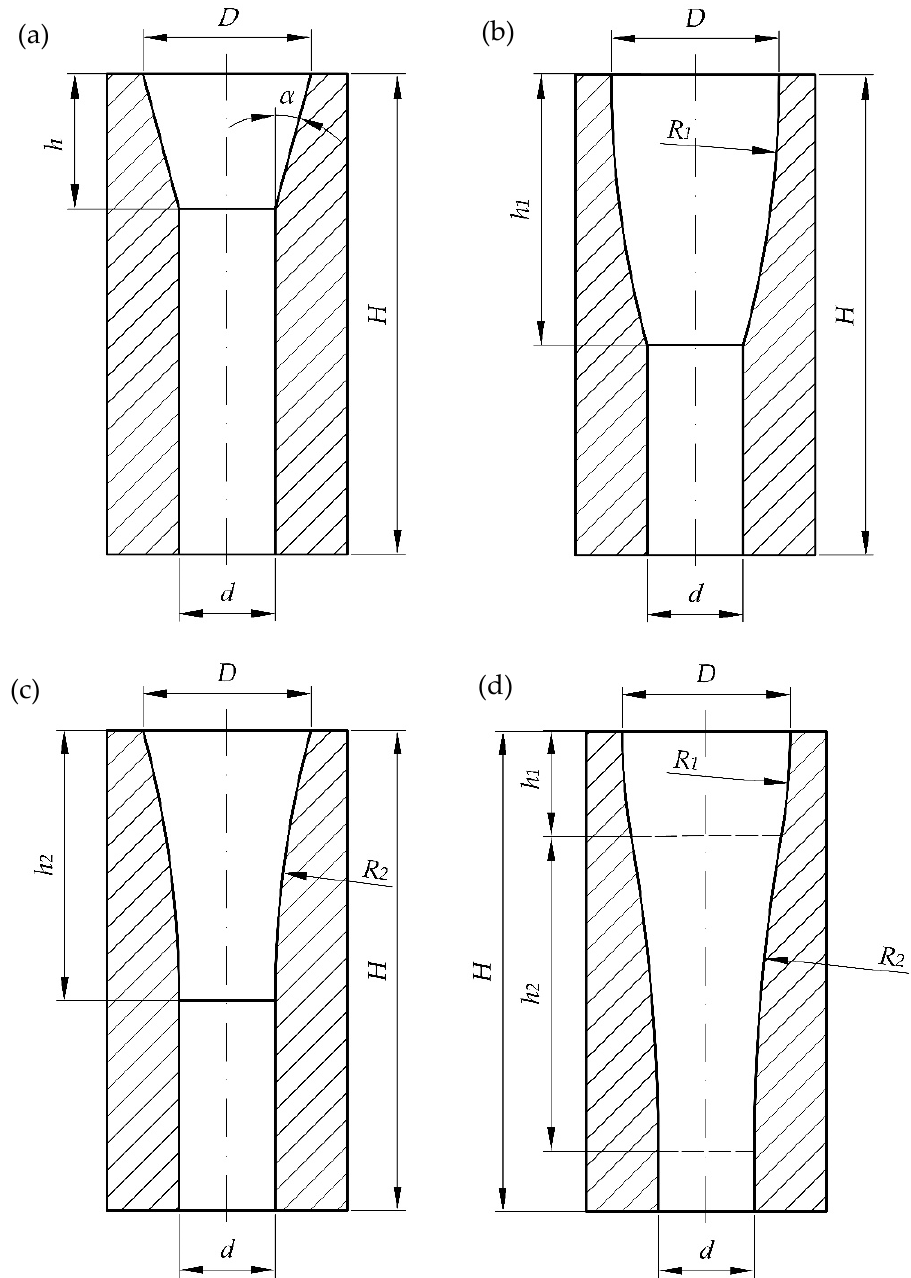
Figure 3. Shapes of the dies under analysis: ( a ) conical-cylindrical (CS), ( b ) with a convex spherical compression section (WK), ( c ) with a concave spherical compression section (WP), ( d ) with a convex section followed by concave section (WKWP).